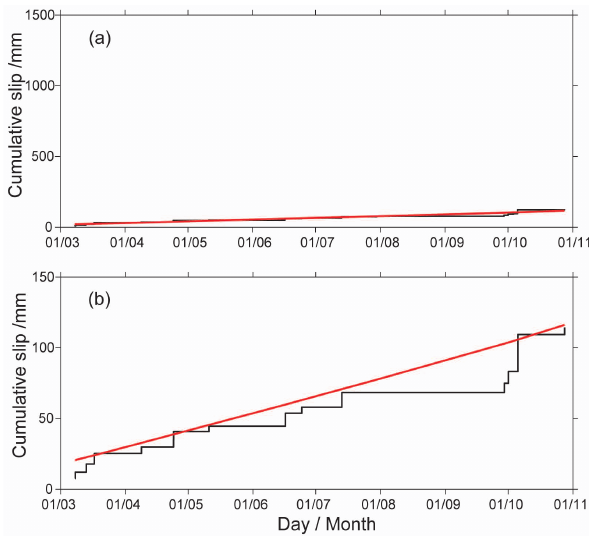
Fig. 7. (a) Cumulative slip plot for the Yinkou 15-plet, with the aspect of coordinates maintaining the same slope as that in Fig. 6a for comparison of the slip rate. (b) The same as (a) , with the vertical coordinate magnified by 10 times. Red line shows the fit of the cumulative slip